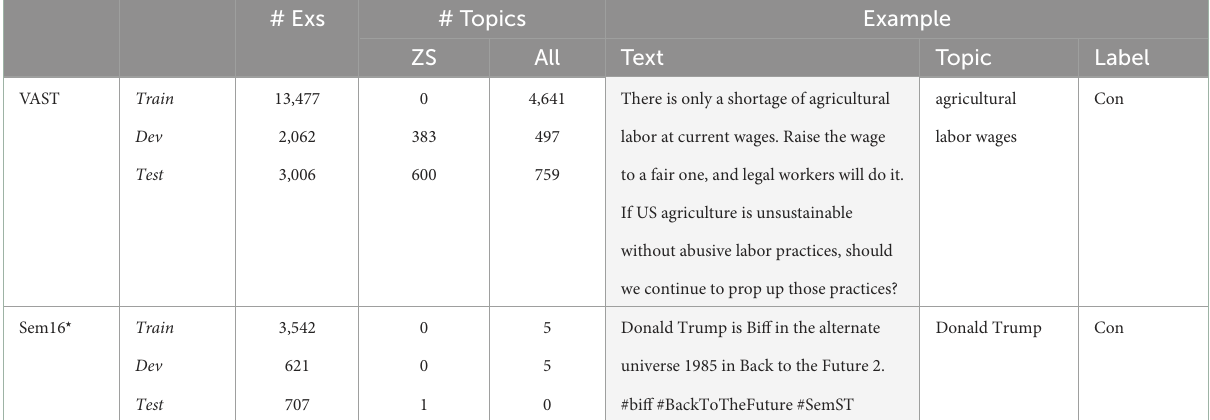
TABLE 1 Dataset statistics for VAST and